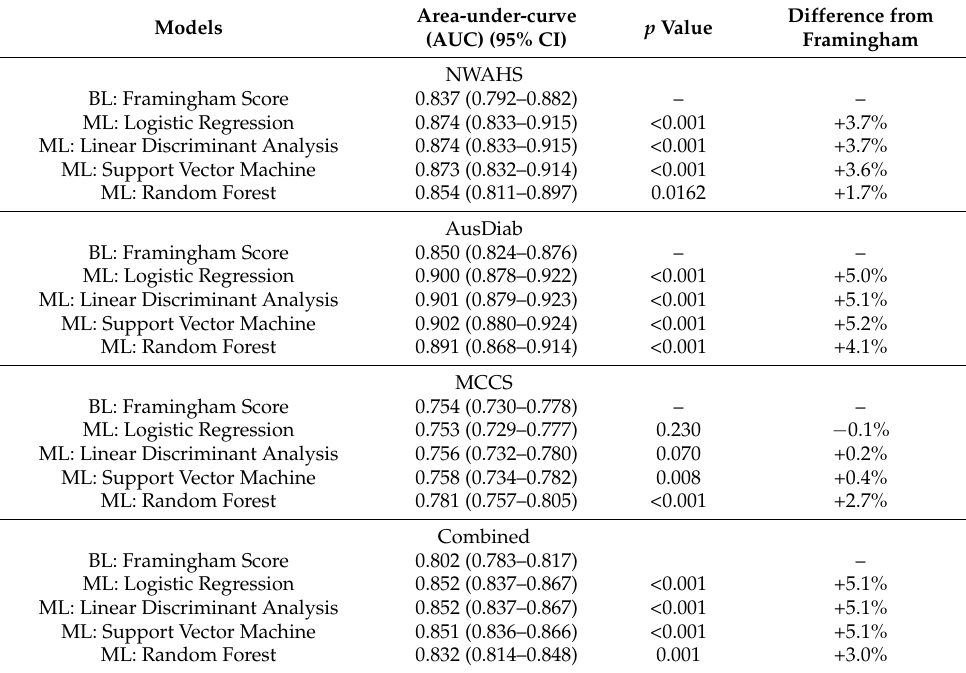
Table 3. Two-fold cross validation: Comparison of the performance of Framingham Score (baseline model (BL)) and four machine learning (ML) models predicting 15-year risk of CVD mortality of NWAHS, AusDiab and MCCS participants, and combined cohorts.